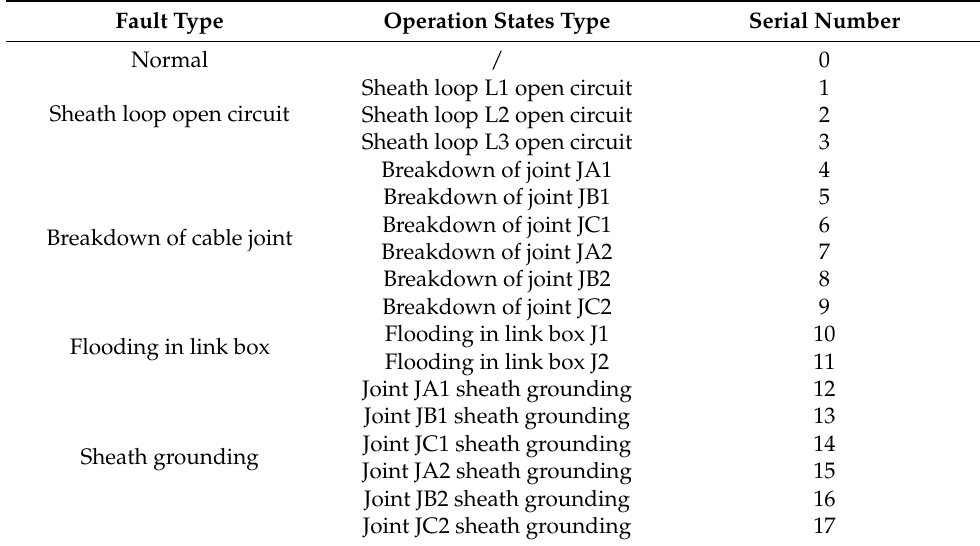
Table 2. HV cable grounding system sheath fault classification.